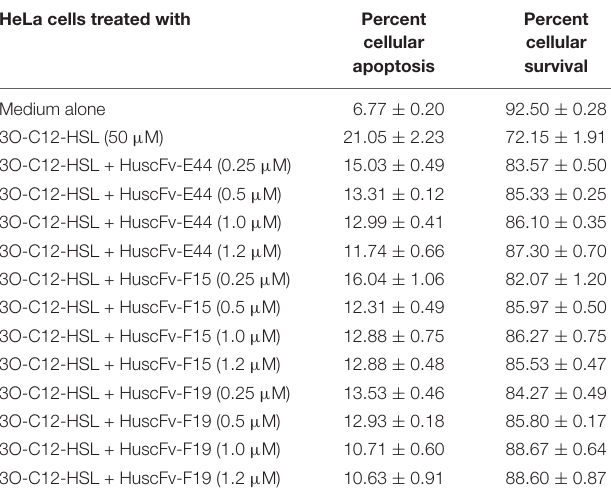
TABLE 2 | Flow cytometric results evaluating the efficacy of HuscFvs using Annexin V-FITC/PI staining for 3O-C12-HSL-mediated cell apoptosis. HeLa cells treated